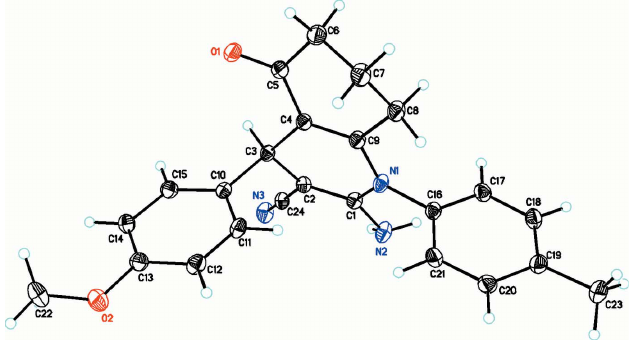
Table 1 Hydrogen-bond geometry (A˚ , (cid:2) ).